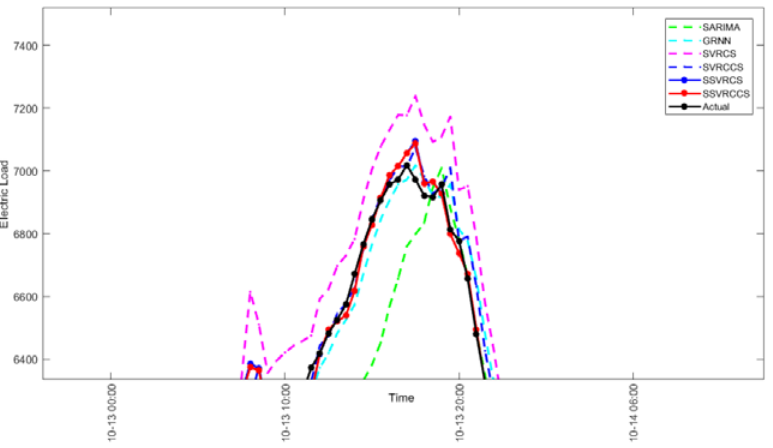
Figure 5. The enlargement comparison of Peak 1 from the compared models for Example 1.